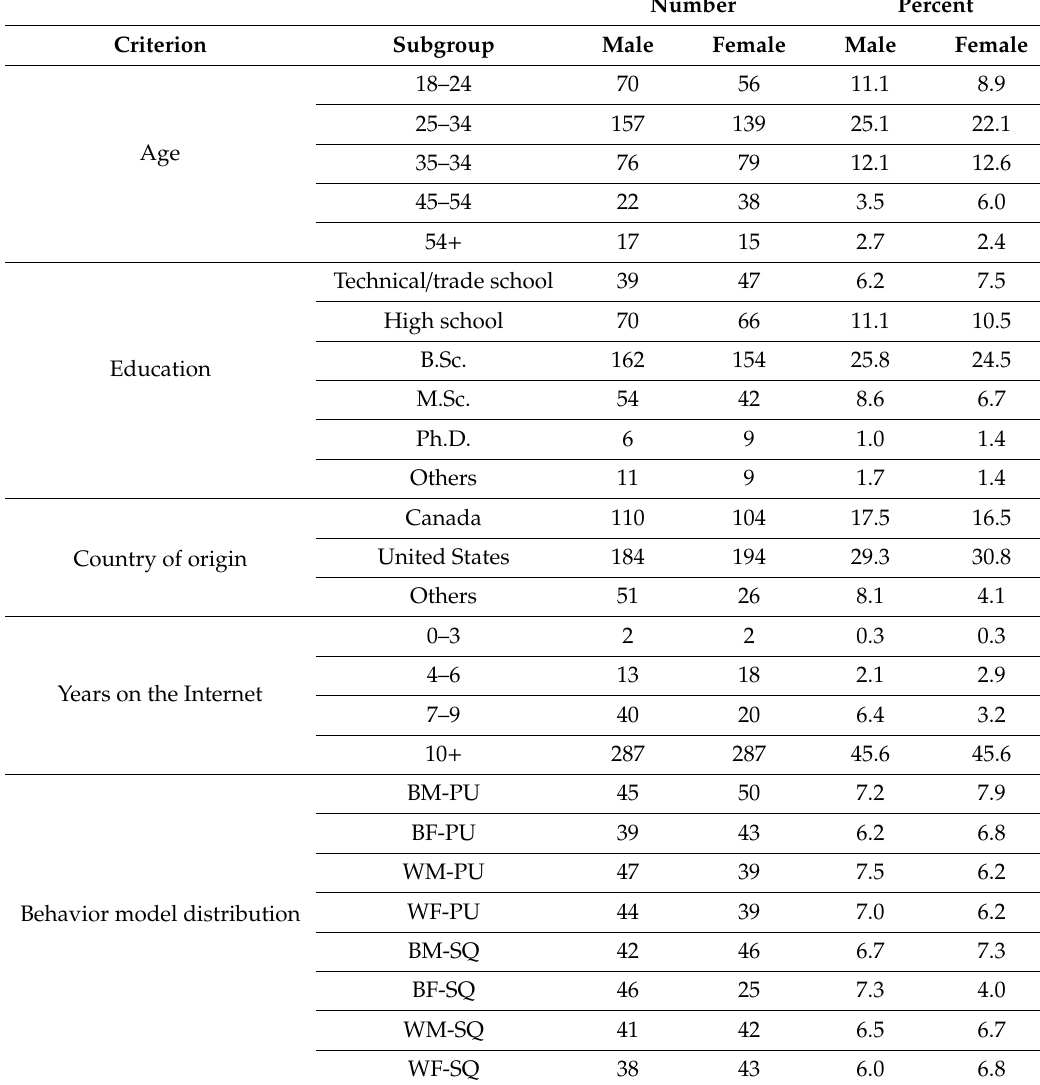
Table 1. Participants’ demographics based on gender (n = 669). BM = black male, BF = black female, WM = white male, WF = white female; PU = push-up, SQ =